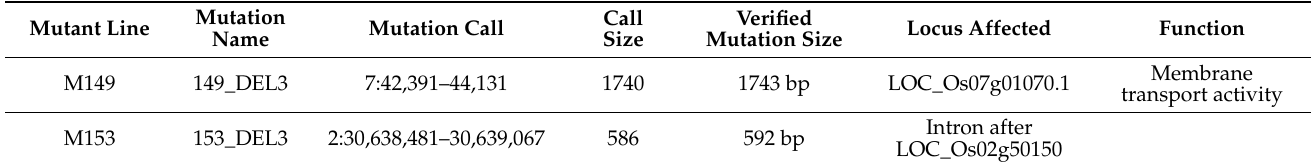
Table 5. Locus affected, and function of confirmed SV